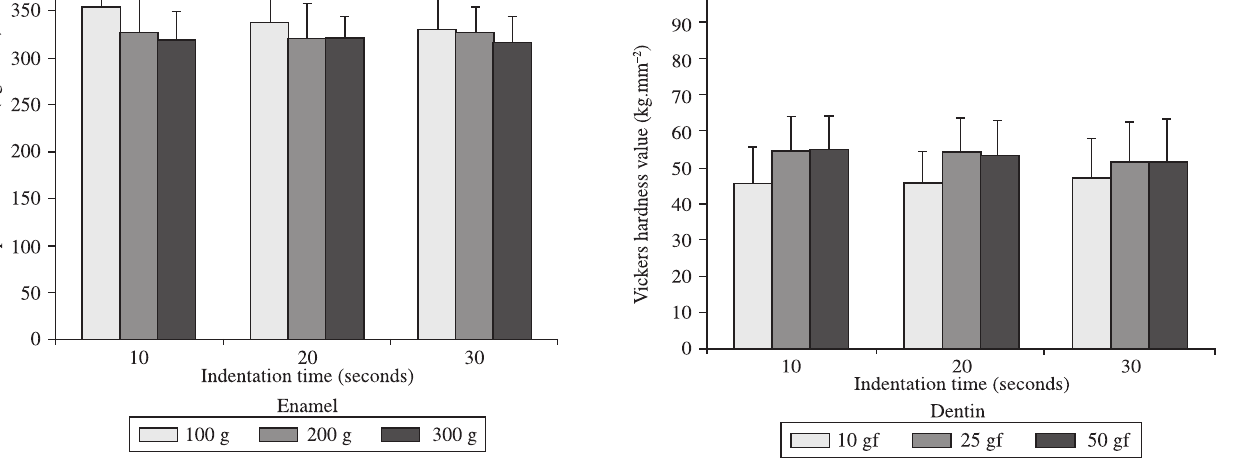
Figure 5. Average VHN values (SD) of dentin at different indentation loads and